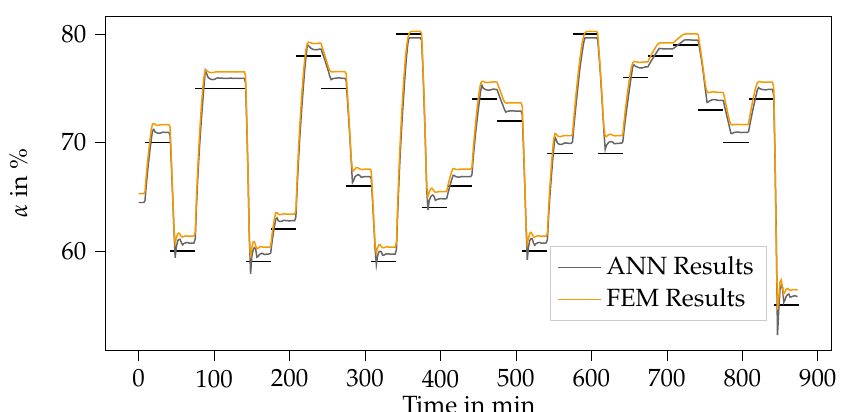
Figure 8. Comparison between the results received by the ANN model and the FE-Model for the NEAT-control